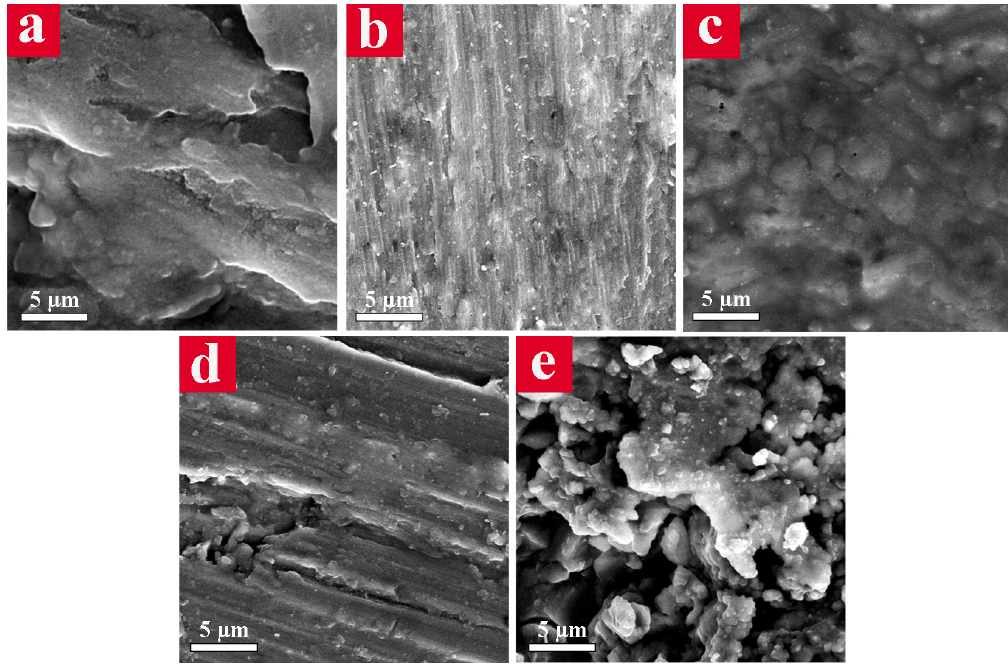
Figure 7. Scanning electron microscope (SEM) micrographs of Al6063 alloys after electrochemical tests: ( a ) CG; ( b ) UFG; ( c ) 15 vol. % CG bimodal; ( d ) 30 vol. % CG bimodal; and ( e ) 45 vol. % CG bimodal.